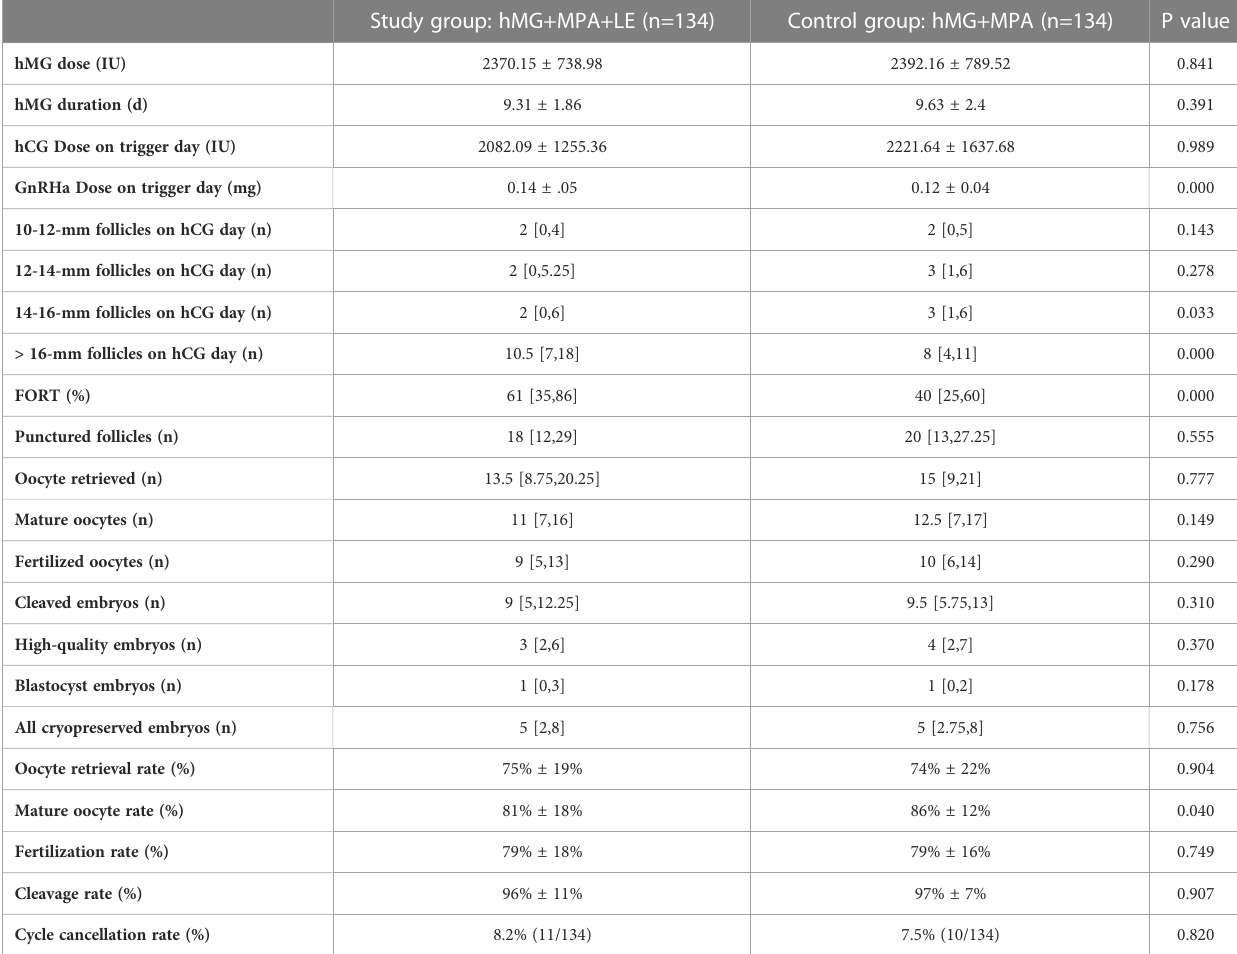
TABLE 2 COS characteristics and outcomes after